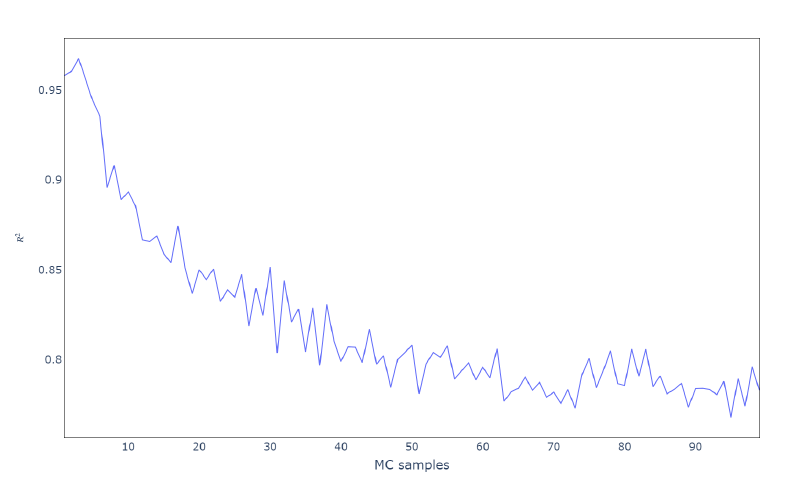
Figure 2. Testing R-squared for different sample sizes.